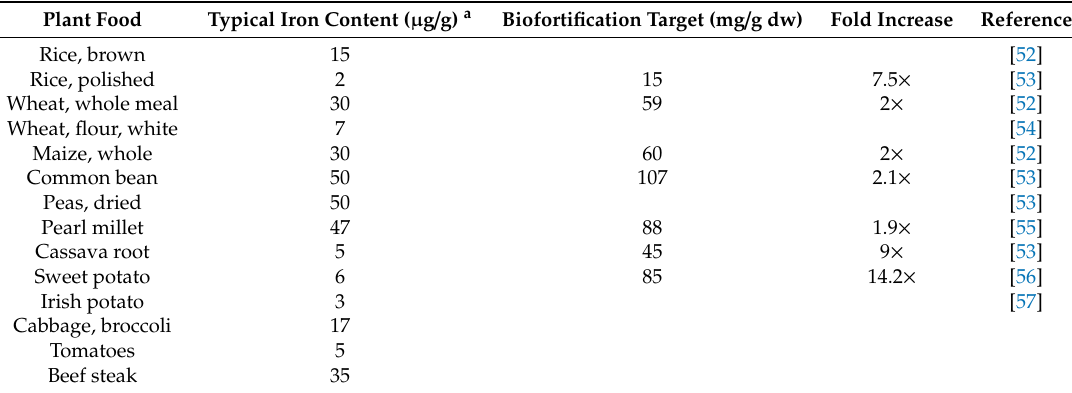
Table 1. Iron concentration in normal and fortified crops